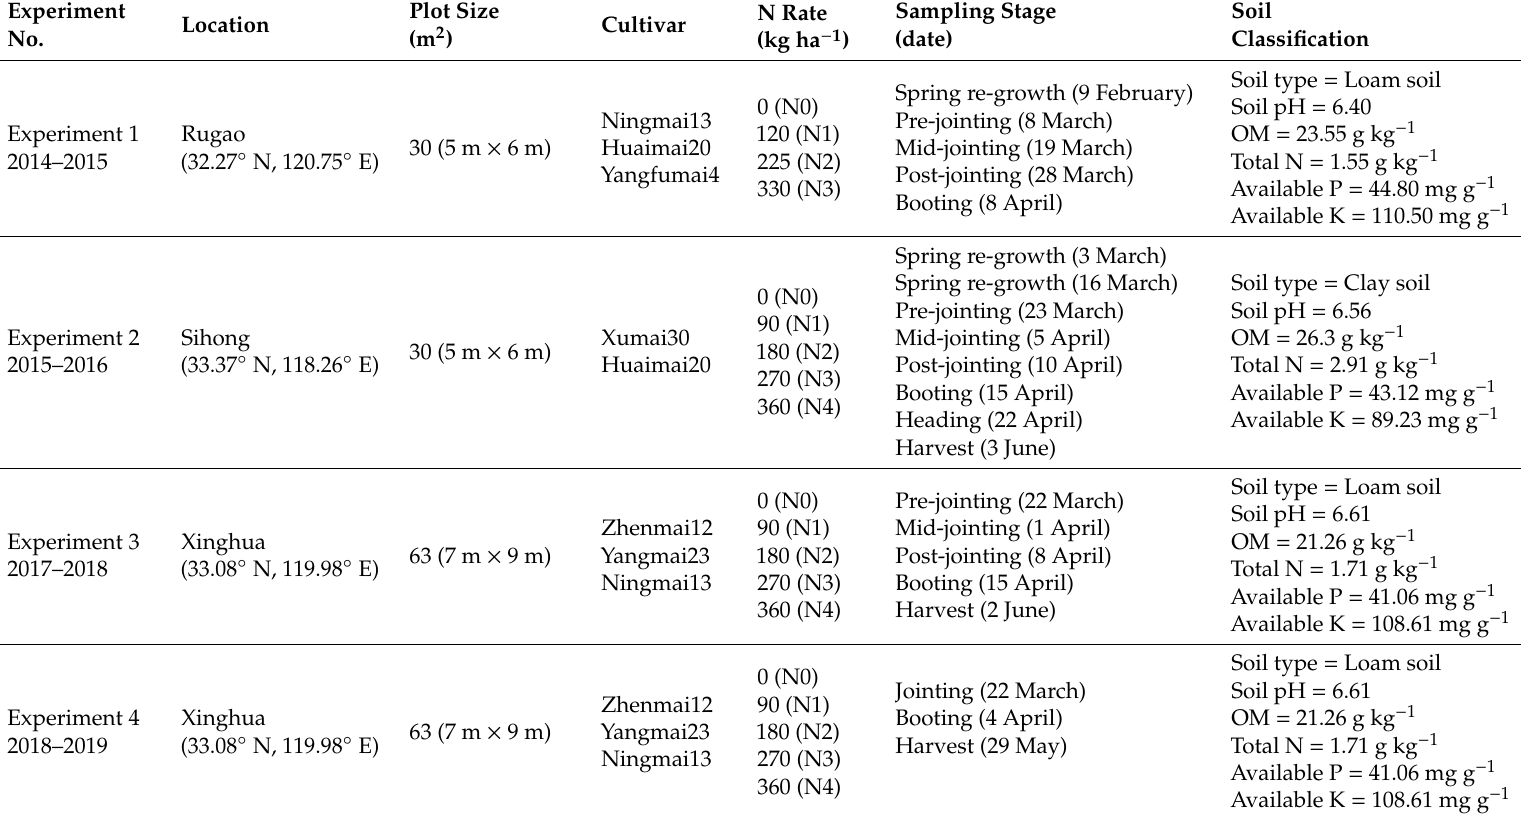
Table 1. Description of the field experimental